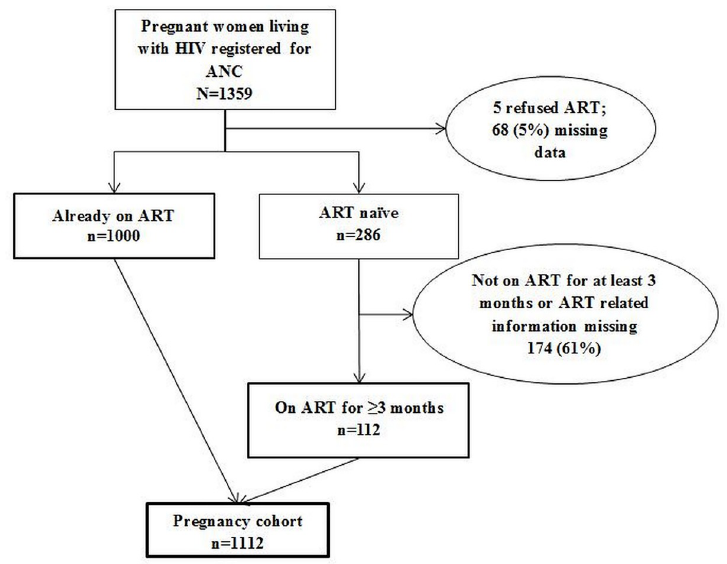
Fig 2. Flowchart describing the pregnancy cohort included in this study, Mazowe district, Zimbabwe (2017). VL– Viral load; ANC- Antenatal Care; ART-Antiretroviral treatment. In the pregnancy cohort, women already on ART were eligible for VL testing at ANC registration if VL results were not available in the previous six months. Women newly initiated on ART were eligible for first VL testing after completing three months of